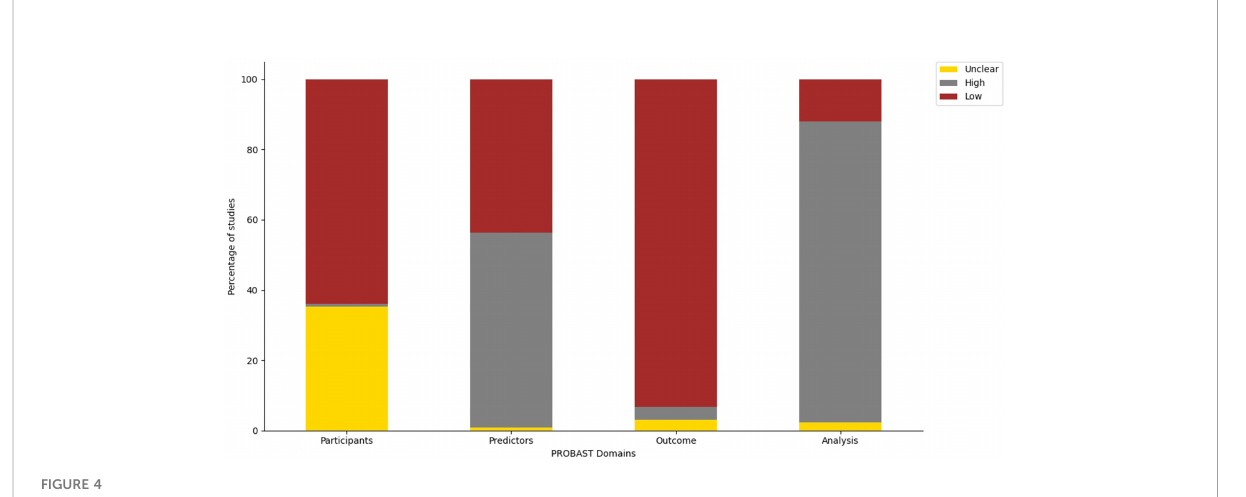
FIGURE 4 Distribution of studies by the PROBAST domains.